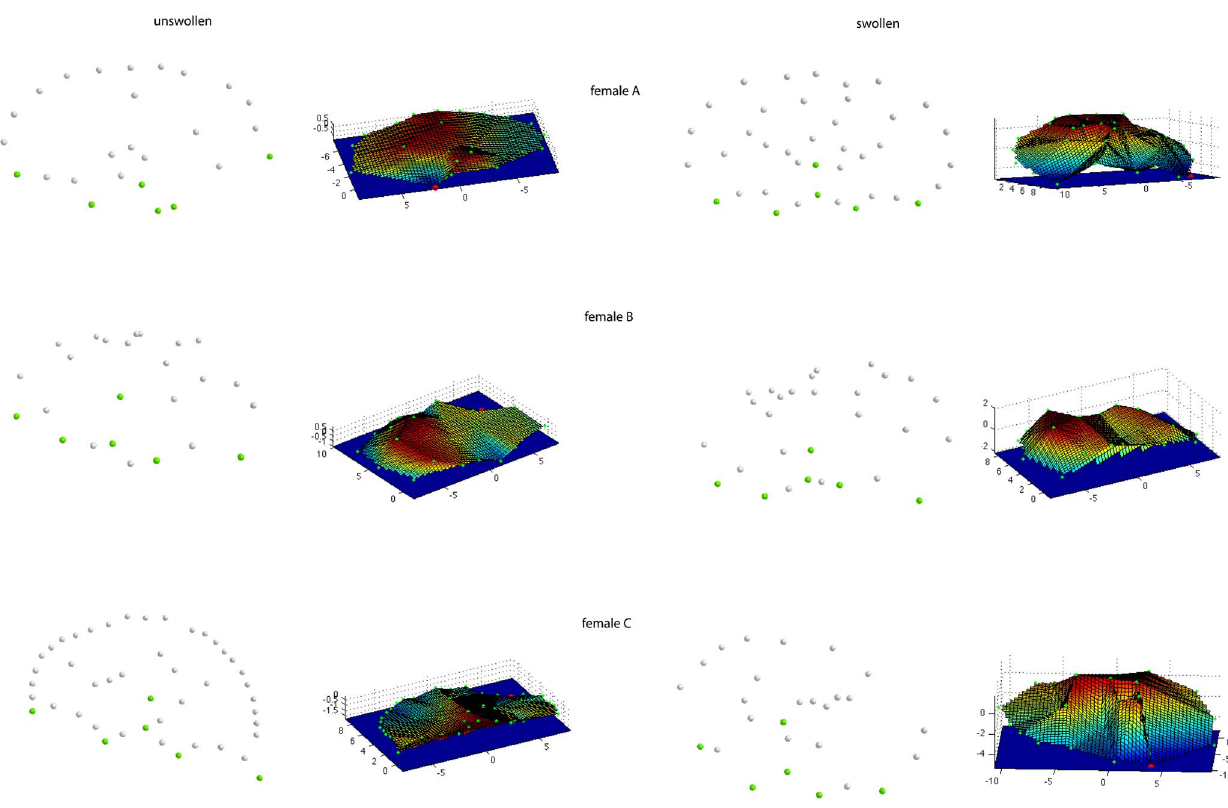
Figure 8. Point-clouds of oriented landmark data and 3D-reconstructions of Barbary macaque anogenital swellings. On the left side, landmark data (green dots represent the homologous points, grey dots show secondary points) and 3D-reconstructions for female A, B, and C in an unswollen state are depicted. The right side shows landmark data and 3D-reconstructions of swollen swelling states.